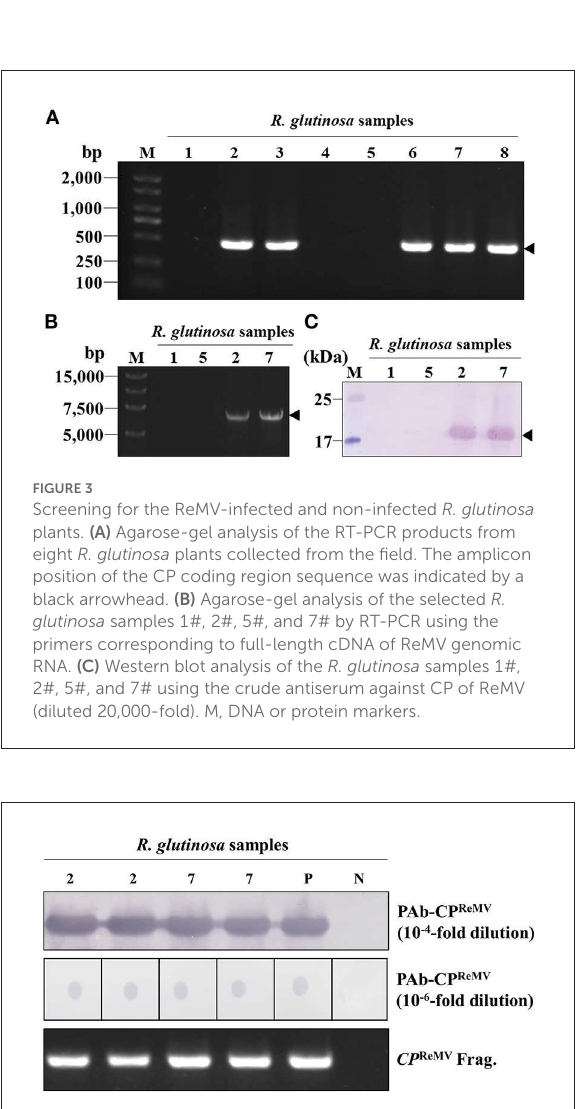
FIGURE4 Establishments of the serological detections using the selected samples and purified polyclonal antibodies against CP of ReMV (PAb-CP ReMV ) from R. glutinosa plants in filed. The R. glutinosa samples 2# and 7# were detected by western blot analysis using the PAb-CP ReMV (diluted 10,000-fold) (upper panel) . The R. glutinosa samples 2# and 7# were detected by immuno-dot-blot assay using PAb-CP ReMV (diluted 1,000,000-fold) (middle panel) . Agarose-gel analysis of RT-PCR products of R. glutinosa samples 2# and 7# using the corresponding CP primers (bottom panel) . M, DNA or protein markers; the P stands for purified His-CP ReMV (positive control); and the N stands for ReMV uninfected R. glutinosa samples (negative control,